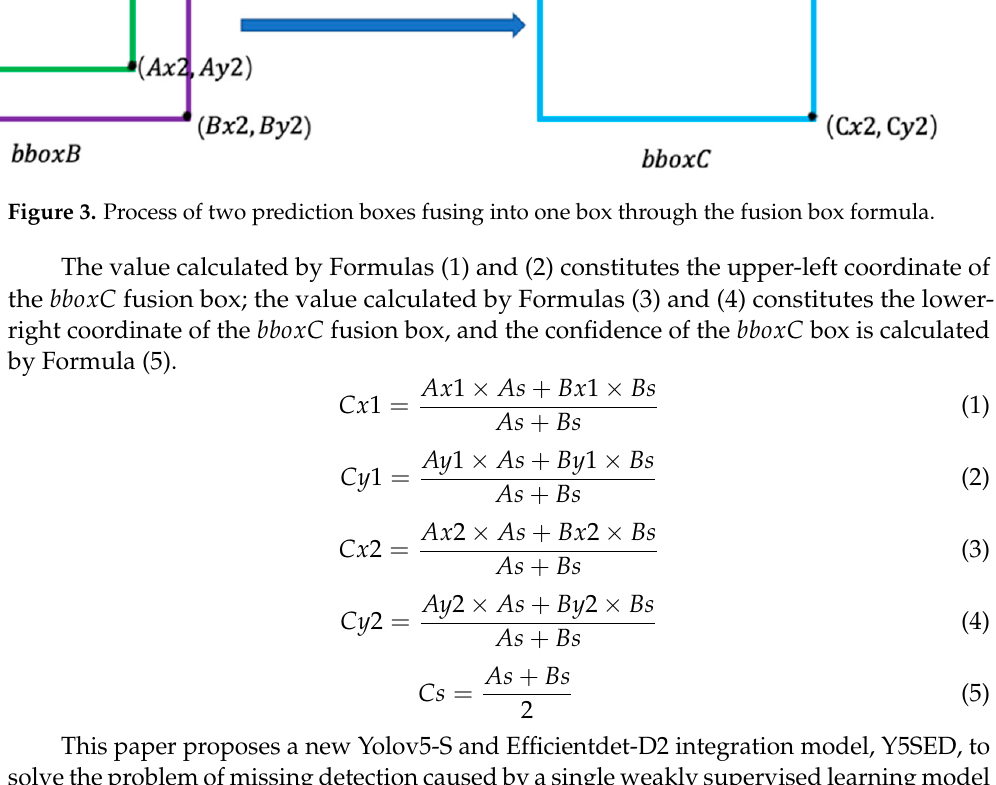
Figure 2. Schematic diagram of WBF and NMS processing multiple prediction results. The red box represents the real red box, and the blue box represents the prediction made by multiple models. Taking two prediction boxes as an example, the calculation method of the weighted box generated by the fusion of two prediction boxes is described. Assuming that the two prediction boxes are 𝑏𝑏𝑜𝑥𝐴: (cid:4670)𝐴𝑥1, 𝐴𝑦1, 𝐴𝑥2, 𝐴𝑦2, 𝐴𝑠(cid:4671)and 𝑏𝑏𝑜𝑥𝐵: (cid:4670)𝐵𝑥1, 𝐵𝑦1, 𝐵𝑥2, 𝐵𝑦2, 𝐵𝑠(cid:4671) , (cid:4666)𝐴𝑥1, 𝐴𝑦1(cid:4667) represent the coordinates of the upper left corner of the 𝑏𝑏𝑜𝑥𝐴 frame; (cid:4666)𝐴𝑥2, 𝐴𝑦2(cid:4667) represent the coordinates of the lower right corner of the 𝑏𝑏𝑜𝑥𝐴 frame, and 𝐴𝑠 represents the confidence degree of the 𝑏𝑏𝑜𝑥𝐴 frame. The same is true for 𝑏𝑏𝑜𝑥𝐵 .